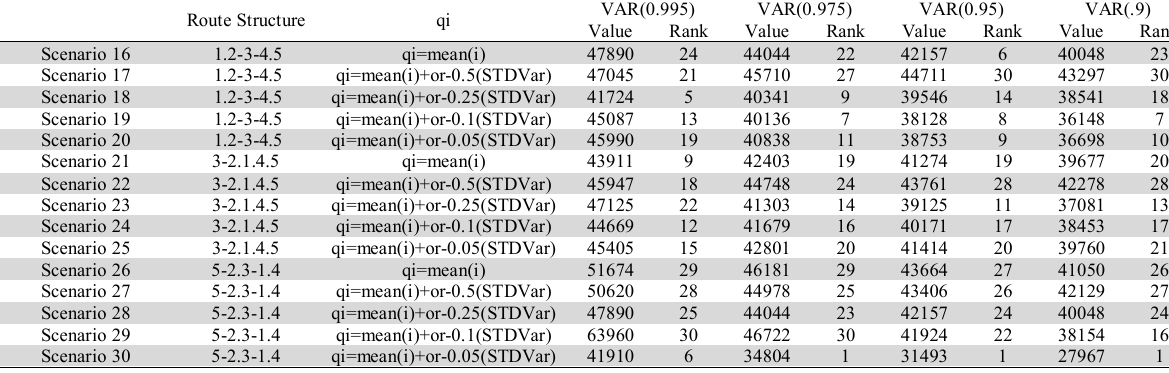
Results of Simulation Optimization for Second 15 Scenarios